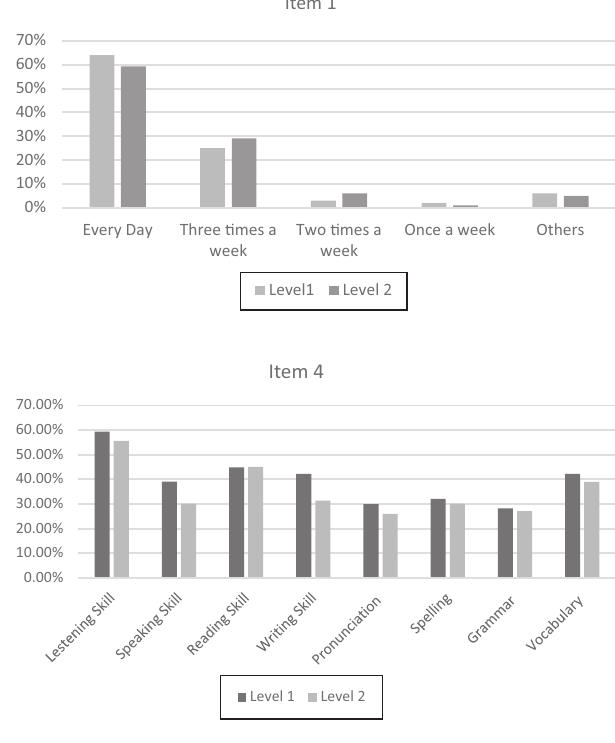
Figure 2. Result of part 2